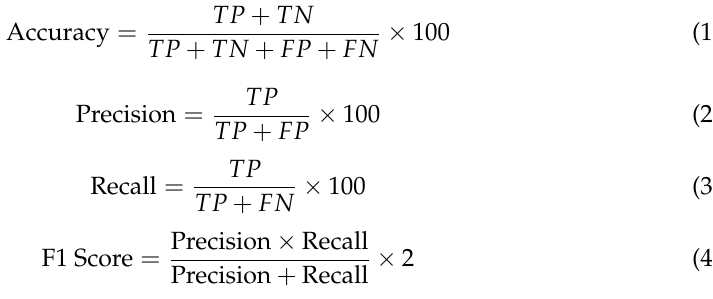
Figure 3. Stacking ensemble model combining CNN and LSTM models.